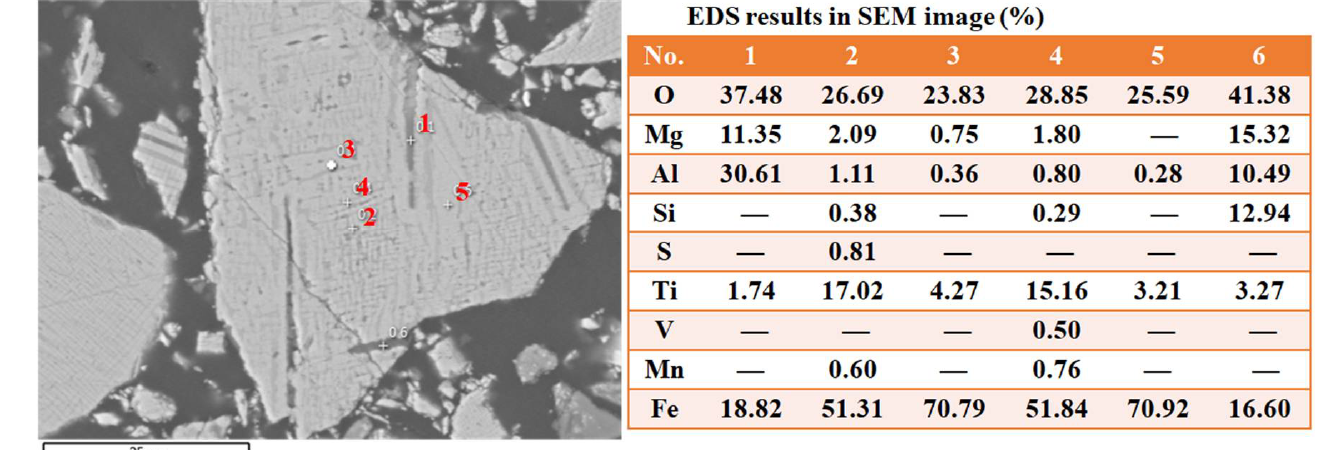
Figure 7. SEM-EDS results for titanomagnetite.